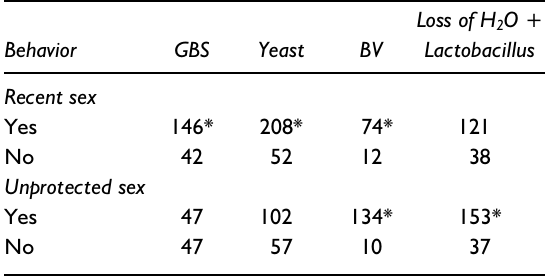
Table 1 Rate of acquisition or loss of vaginal flora